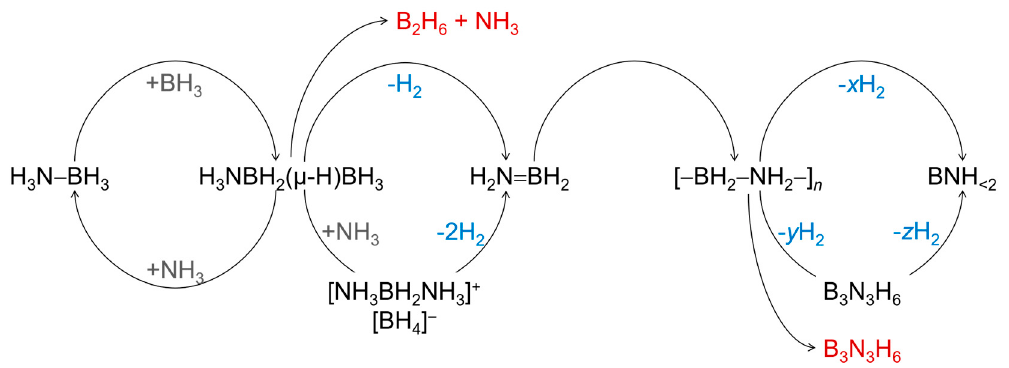
Figure 8. A possible mechanism of the thermolytic decomposition of ammonia borane, as suggested in reference [177]. Non-crystalline polyaminoborane and polyborazylene are represented by [ − BH 2 − NH 2 − ] n and BNH <2 .